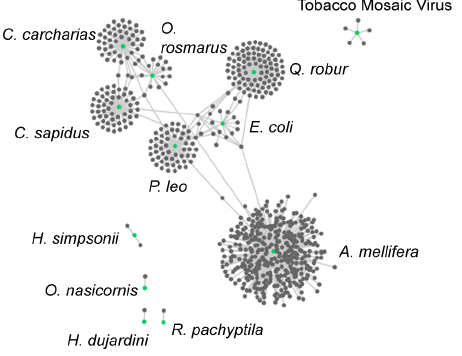
Figure 2. Manual Species Interactions. Taxon interaction network generated manually by reading through all of the text on an EOL taxon page and collecting scientific and common names. These associations are from the test species